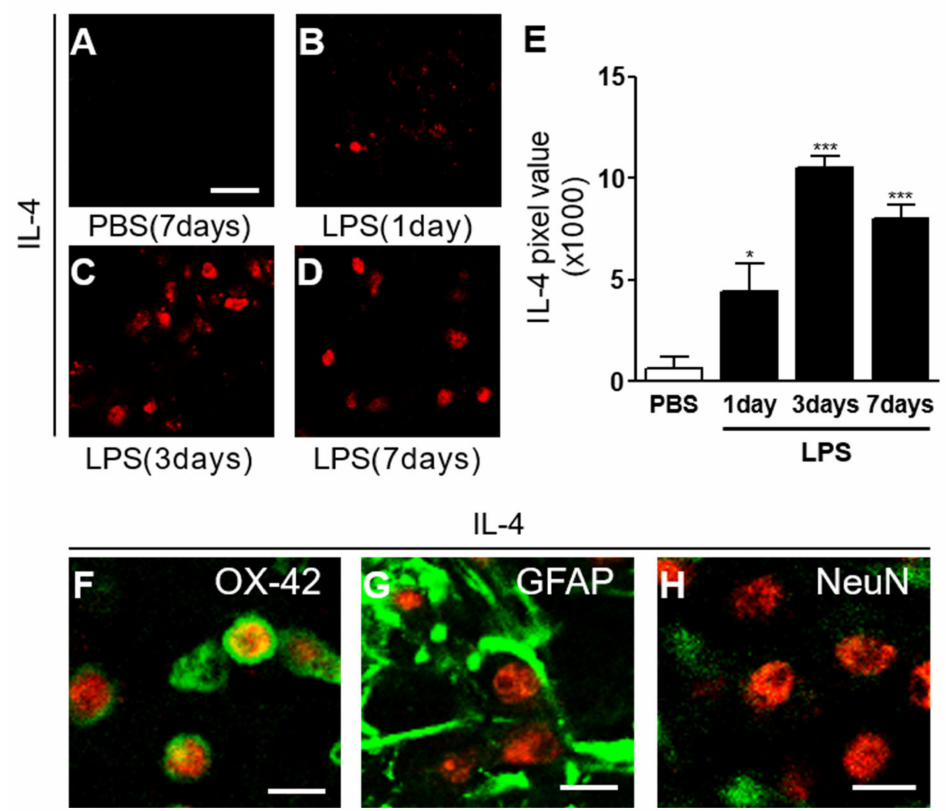
Figure 2. IL-4 expression in LPS-lesioned striatum in vivo. Animals received a unilateral injection of PBS ( A ) or LPS ( B – D ) into the rat striatum and were transcardially perfused at various time points. The brain sections were processed for immunohistochemical staining. ( A – E ) Immunofluorescence images of IL-4 ( A – D ) and quantification ( E ) in the rat striatum at indicated time points. Scale bar, 25 µ m. * p < 0.05, significantly different from PBS (control). *** p < 0.001 significantly different from PBS-injected control. Mean ± SEM; n of animals = 4 to 6 in each group, ANOVA with Bonferroni test. ( F – H ) Double immunofluorescence images of IL-4 (( F ), red) and OX-42 (( F ), green), or IL-4 (( G ), red) and GFAP (( G ), green), or IL-4 (( H ), red) and NeuN (( H ), green), and both images are merged (yellow). n of animals = 4. Scale bar, 15 µ